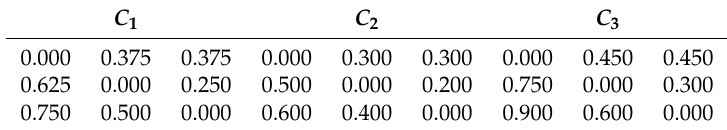
Table 2. Prior probabilities of regional mobility.